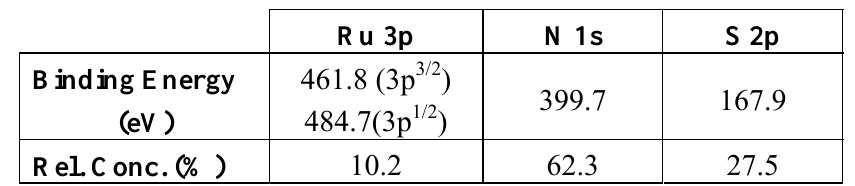
Table 1. Binding energy and the relative concentrations of Ru , N and S in the Creutz- Taube ion powder sample with toluenesulfonate (TOS) as the counter